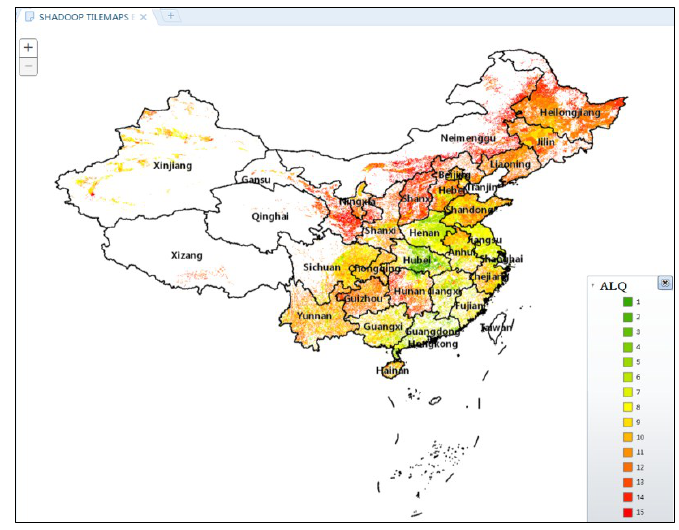
Figure 15. The map tiles of the national arable land quality dataset.